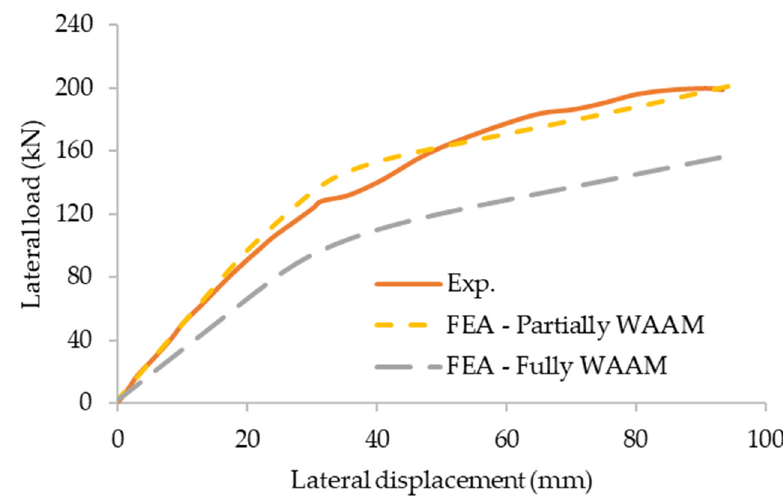
Figure 8. Lateral load-deflection behaviour of modular connection.